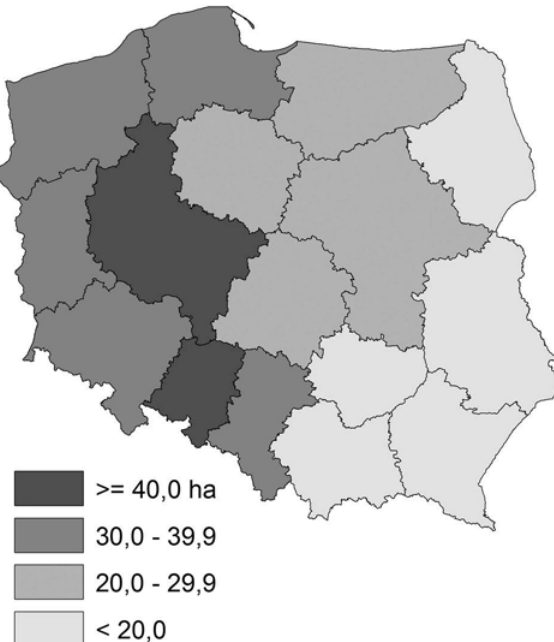
Fig. 9. Changes in the proportions of farms of over 1 ha in area, 2004 and 2014 (%). Source: own calculations based on the IJhArS report.